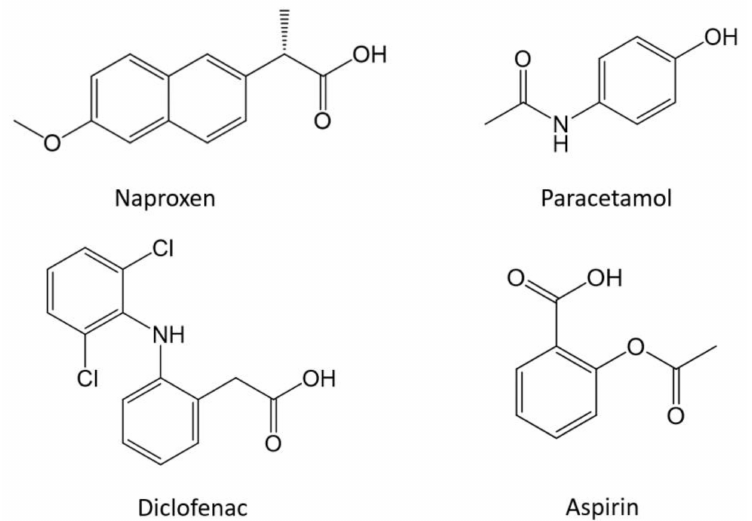
Figure 1. Chemical structure of four main